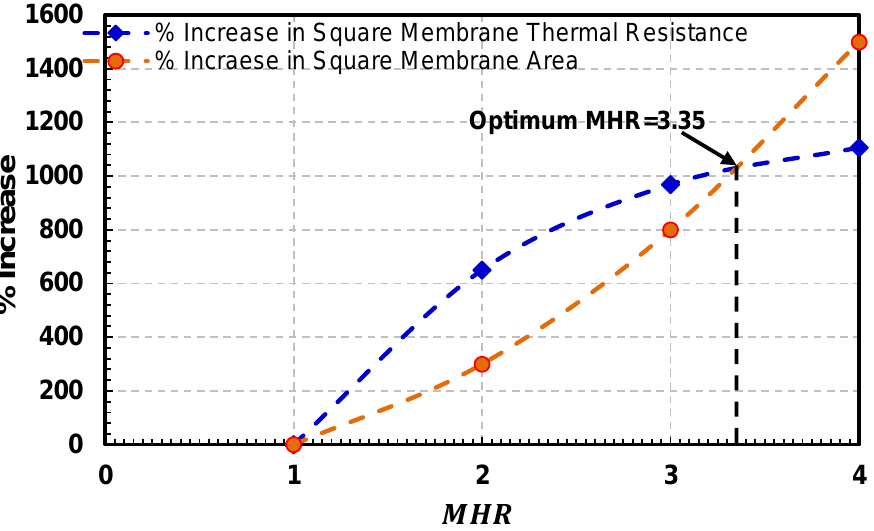
Figure 9. Plot showing the percentage increase in the square membrane area and the percentage increase in the thermal resistance with the increasing MHR for square membrane hot-film sensors FS1, FS3, FS5 and FS7. Up to MHR = 3.35, the percentage increase in sensors’ thermal resistance is more pronounced viz-a-viz the percentage increase in the membrane area. However, beyond MHR = 3.35, the change is opposite, thus using a MHR > 3.35 for square membranes is not very economical in terms of corresponding sharp increase in sensor size.